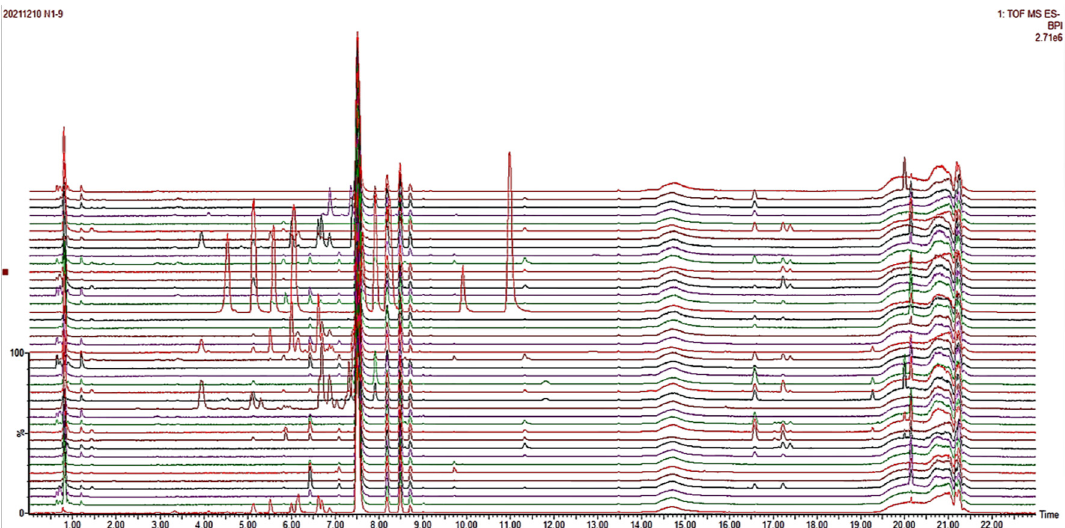
Figure 1. The total ion chromatography (TIC) of T. hemsleyanum extracts from di ff erent origins.